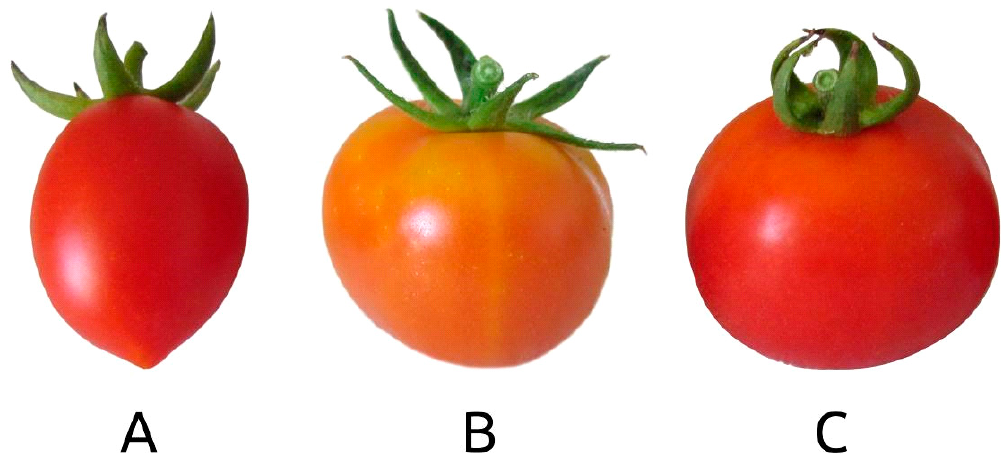
Figure 1. Fruits of the three tomato landraces harvested at commercial ripening: ( A ) Manduria; ( B ) Giallo di Crispiano; ( C ) Regina.